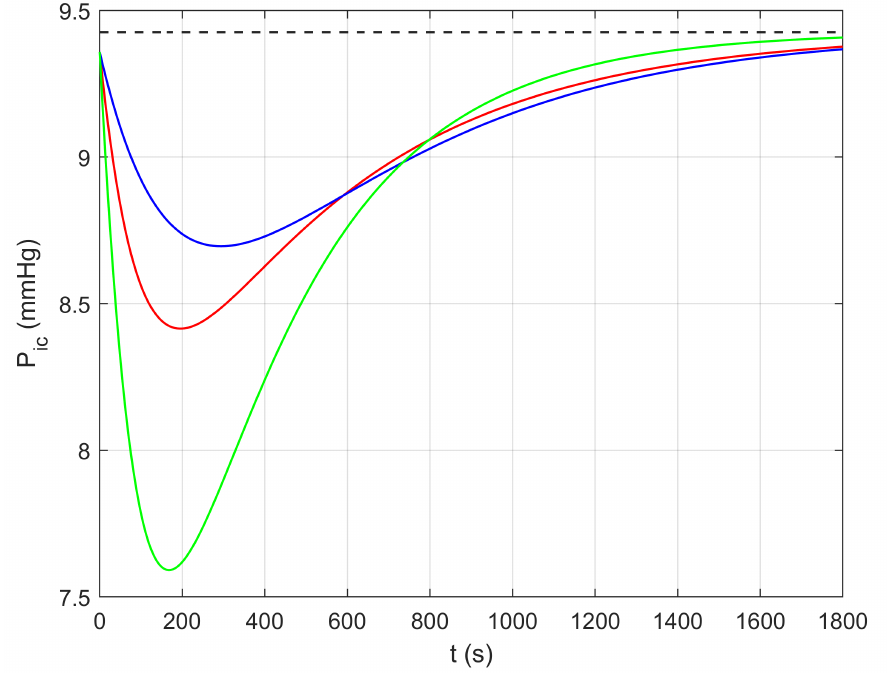
Figure 4. Intracranial pressure P ic time behavior (solid red line for κ 1 = 0.002, κ 2 = 0.01, M 1 = 0.1738, M 2 = 3.46 × 10 − 4 ; solid blue line for κ 1 = 0.002, κ 2 = 0.005, M 1 = 0.1738, M 2 = 3.46 × 10 − 4 ; solid green line for κ 1 = 0.003, κ 2 = 0.01, M 1 = 0.1738, M 2 = 5.19 × 10 − 4 ) and its reference value P icr (dashed